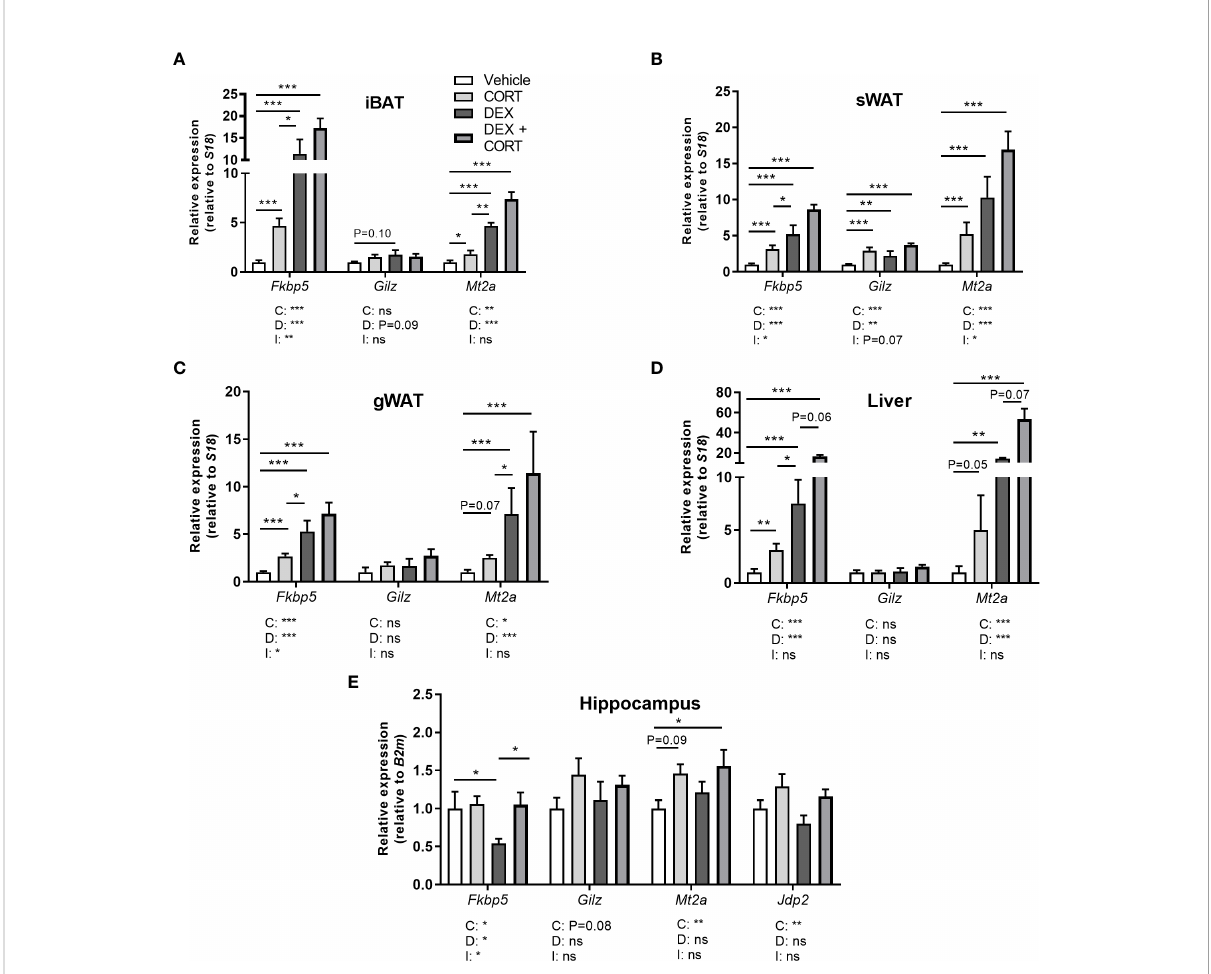
FIGURE 5 Corticosterone adds to dexamethasone-induced gene expression. Mice received a high-fat diet mixed with dexamethasone (DEX) or vehicle (VEH) and were subcutaneously implanted with low-dose (5 mg) corticosterone (CORT) or vehicle pellets for 3.5 weeks. (A – D) DEX increased expression of GR target genes Fkbp5, Gilz and Mt2a stronger than CORT in interscapular brown adipose tissue (iBAT), subcutaneous white adipose tissue (sWAT), gonadal white adipose tissue (gWAT) and liver, while the induction after DEX + CORT was highest. (E) In the hippocampus, DEX decreased Fkbp5 expression and did not regulate Gilz and Mt2a expression. DEX + CORT normalized Fkbp5 , and induced Gilz , Mt2a and Jdp2 expression. Statistical signi fi cance was calculated using 2-way ANOVA analysis. Depicted below the graphs are the P-values of the ANOVA tests for either CORT (C), DEX (D) or the interaction between CORT and DEX (I). *P < 0.05, ** P < 0.01, ***P < 0.001. 'ns' means 'not signi fi